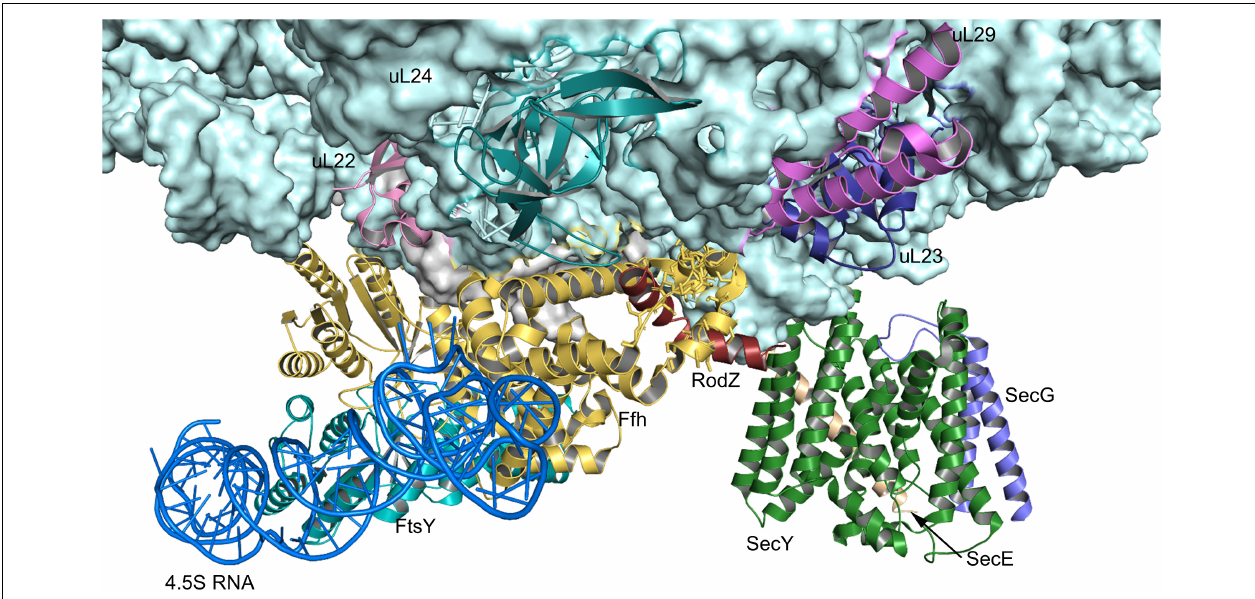
FIGURE 5 | Structure of the quaternary RNC-SRP-FtsY-SecYEG complex. Structure of the quaternary complex (PDB 5NCO), depicting an early state of co-translational protein insertion. The subunits SecY, SecE and SecG of the SecYEG translocon are indicated by green, orange and blue color, respectively. The color code of the FtsY-SRP complex is as in Figure 4 and the nascent PhoA is shown in dark-red. Please note that in this structure, the SecYEG translocon is only tentatively fitted and would have to tilt by ∼ 20 ◦ to be accommodated within the membrane (Jomaa et al.,